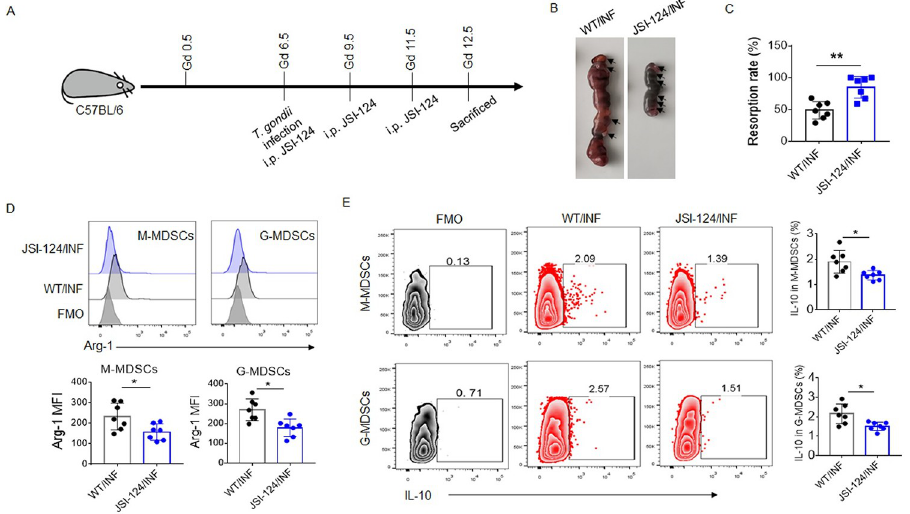
Fig 5. JSI-124 inhibits decidual MDSCs activation during T . gondii infection in vivo . (A) Schematic of the experiment. The detailed protocol is described in the Materials and Methods . (B–C) Representative picture and statistical analysis of uteri from the T . gondii -infected pregnant WT mice treated with (INF/JSI-124) or without (WT/ INF) JSI-124. Black arrows indicated resorption sites. Each symbol represents an individual animal, and the median is indicated (n = 7). (D) Representative flow cytometry results and statistical analysis of Arg-1 expression in decidual M-MDSCs and G-MDSCs from WT/INF and INF/JSI-124 mice (n = 7). (E) Representative flow cytometry results and statistical analysis of the intracellular level of IL-10 in decidual M-MDSCs and G-MDSCs from WT/INF and INF/JSI- 124 mice (n = 7). Cells from the WT/INF mice were used for the FMO conditions. The data are presented as the mean ± SD, * p < 0.05, ** p < 0.01, Student’s t